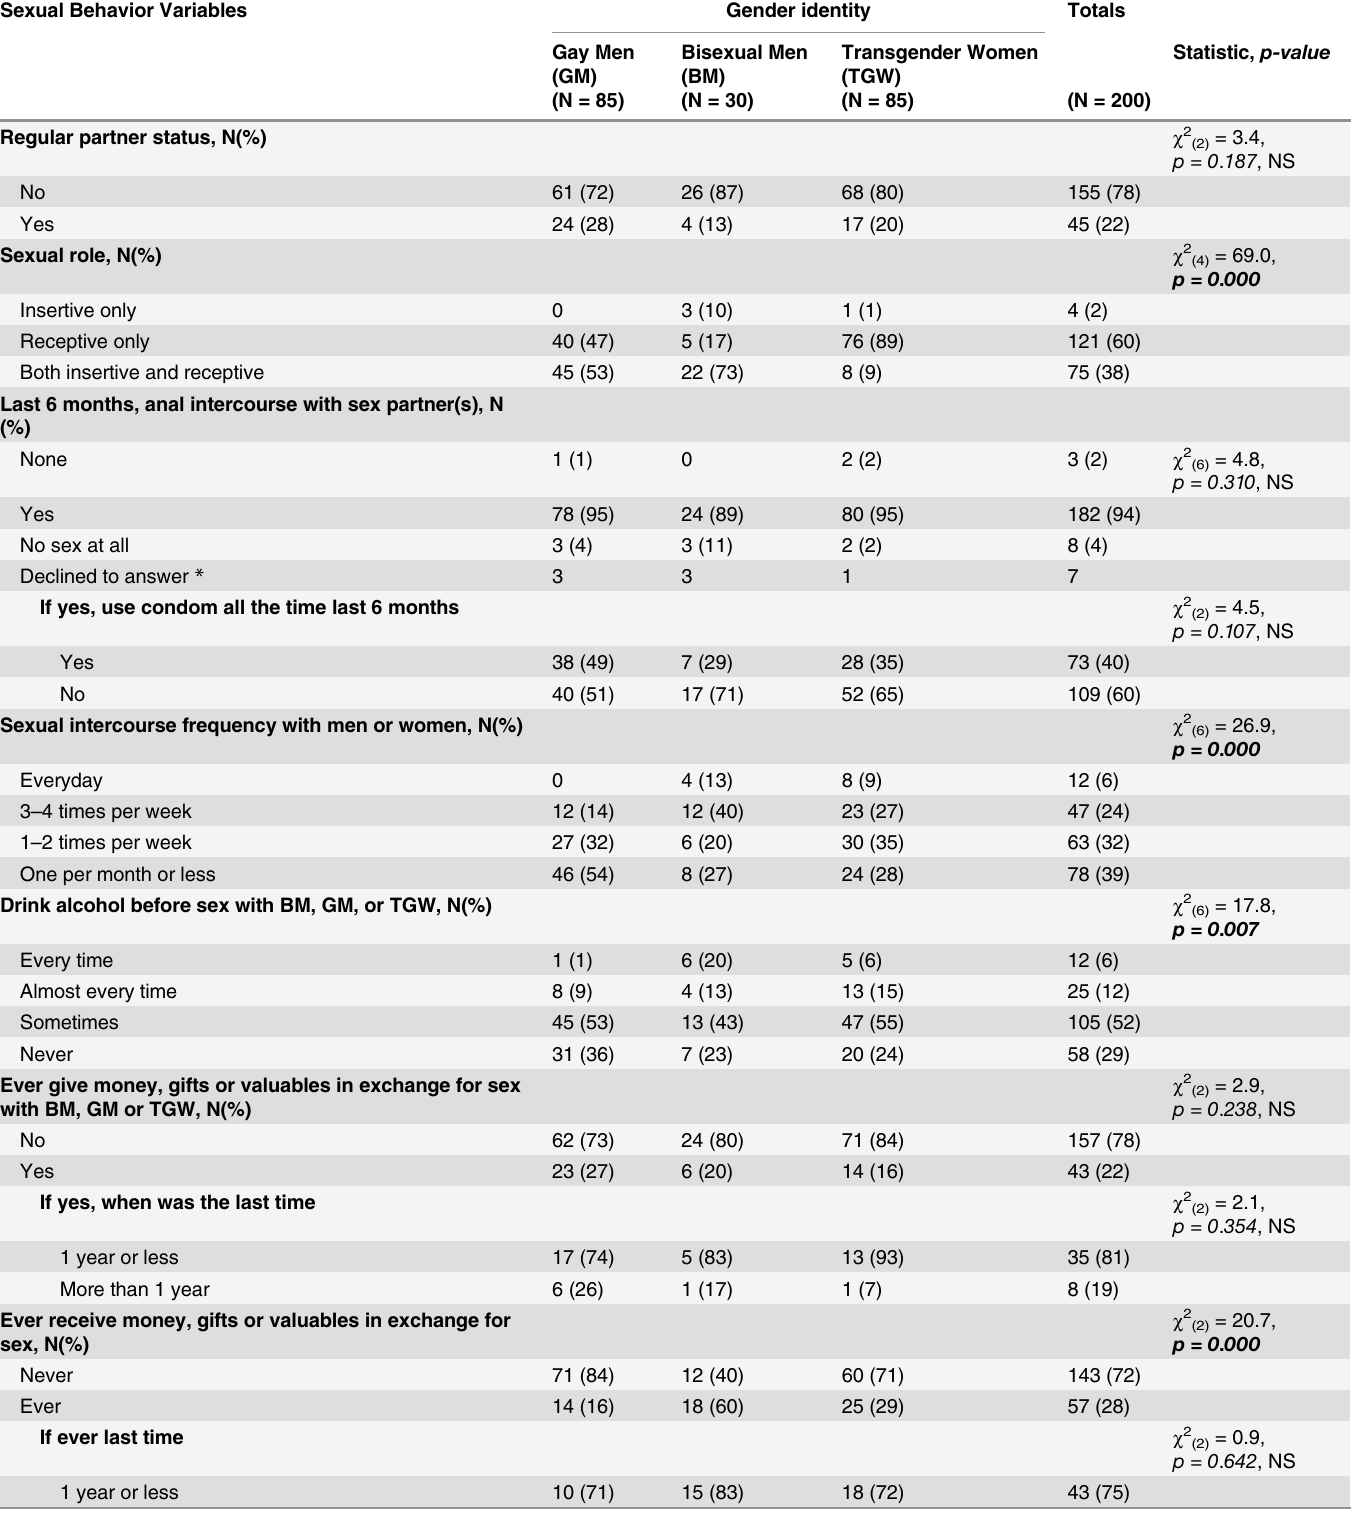
Table 2. Frequency of sexual and other behaviors, by gender-identity of MSM subjects in Chiang Mai, Thailand, 2012 –